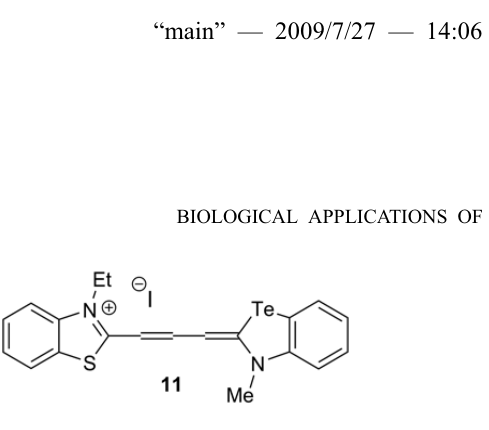
Fig. 9 – Molecular structure of the thiatelluracarbocyanine iodide 11 .